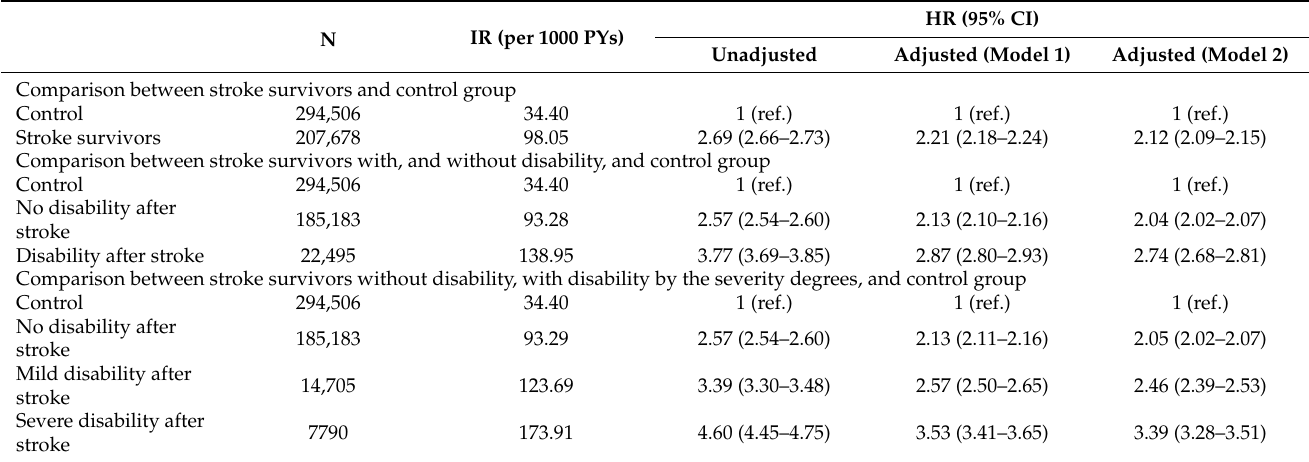
Table 2. Comparison of the risk of developing depression in stroke survivors and matched control